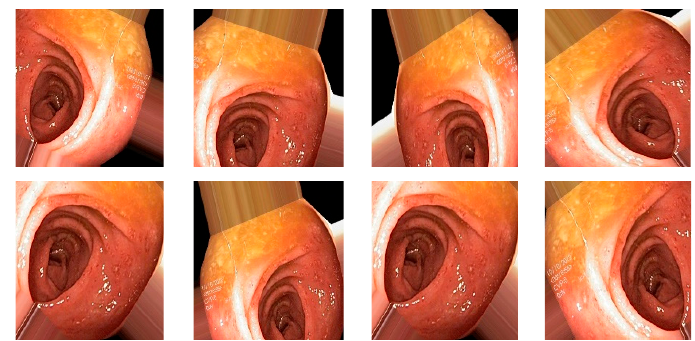
Figure 6. Augmented image samples.